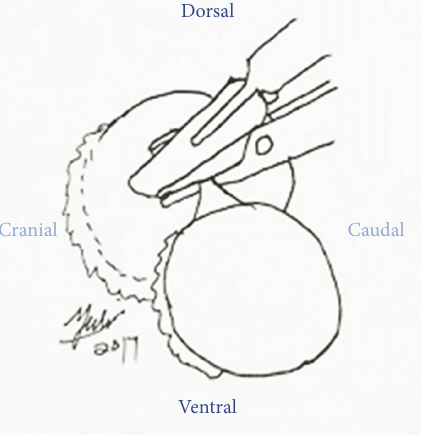
Figure 8: The optic nerve was transected between the Rochester Pean forceps by using scalpel blade